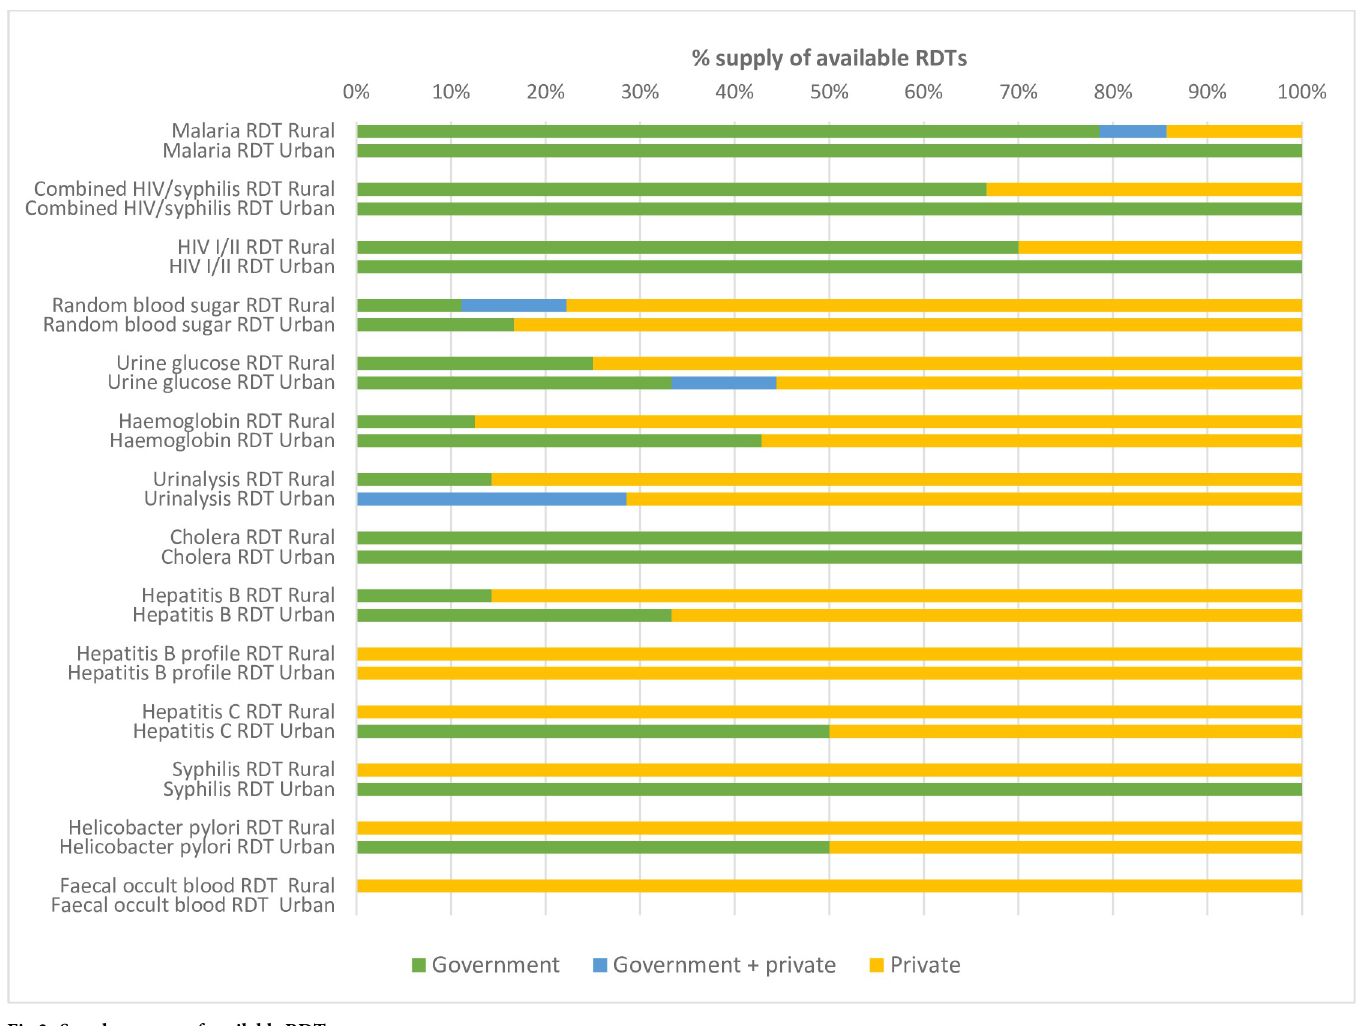
Fig 3. Supply sources of available